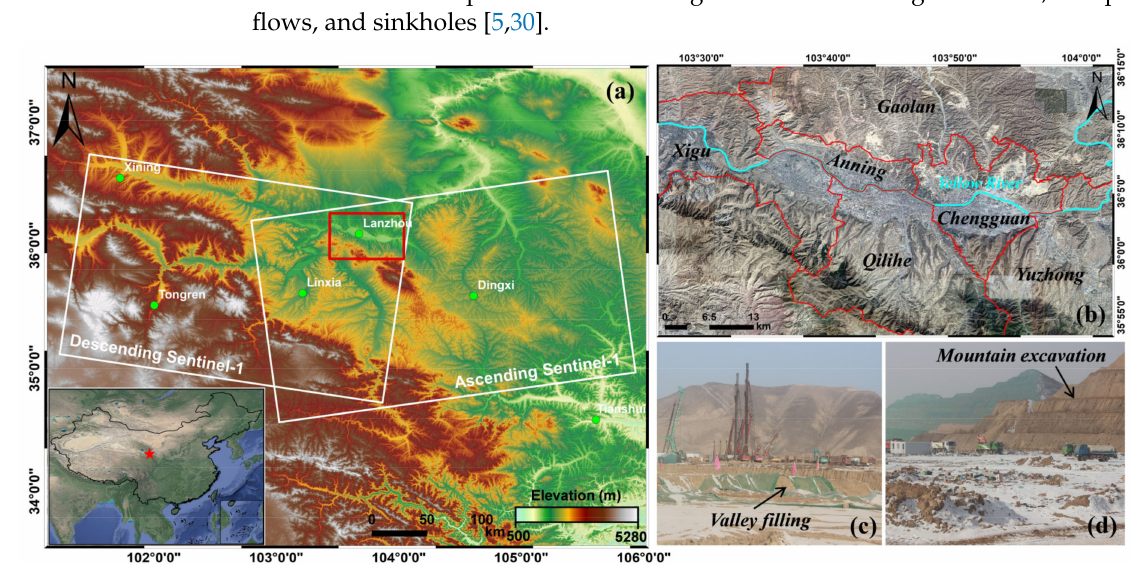
Figure 1. Overview of the study area: ( a ) location of Lanzhou (red star and red rectangle) as well as coverage of SAR images used in this study (white rectangles); ( b ) remote sensing image of the study area acquired in 2020, where red lines indicate the boundary of the county and the district; and scene photos of valley filling ( c ) and mountain excavation ( d ) in